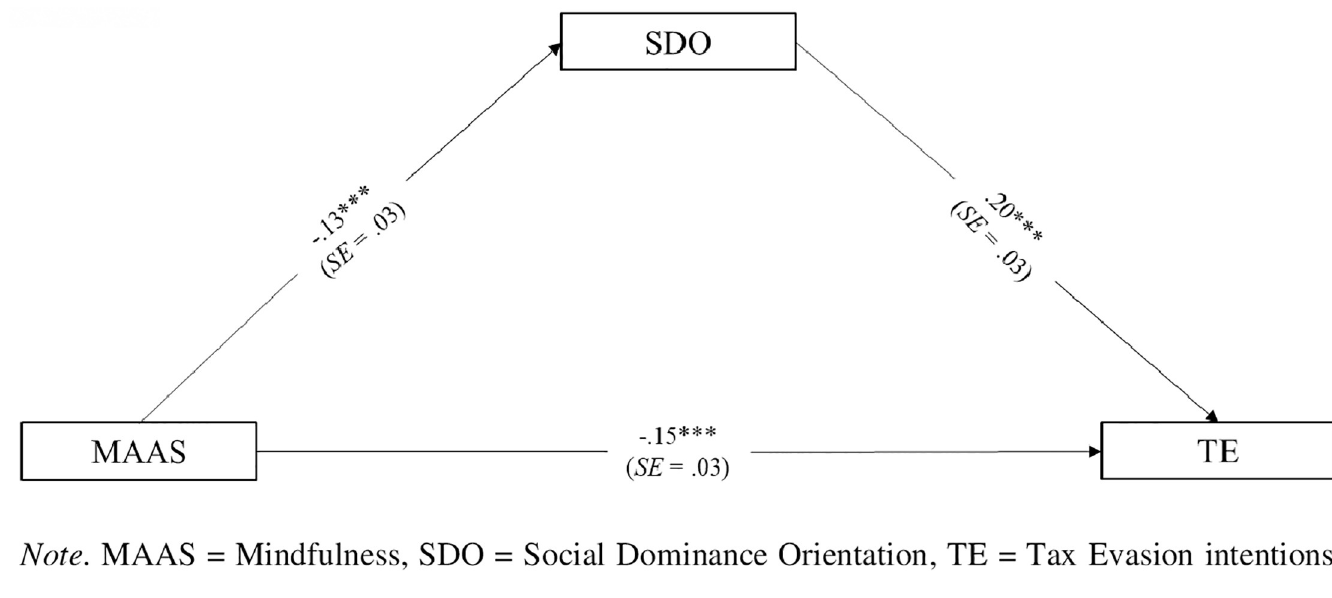
Fig 1. Mediation analysis model in Study 1 ( N = 1,175): Standardized